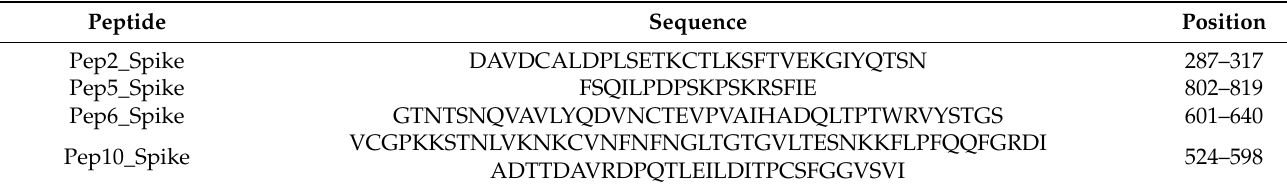
Table 1. List of peptides used for this